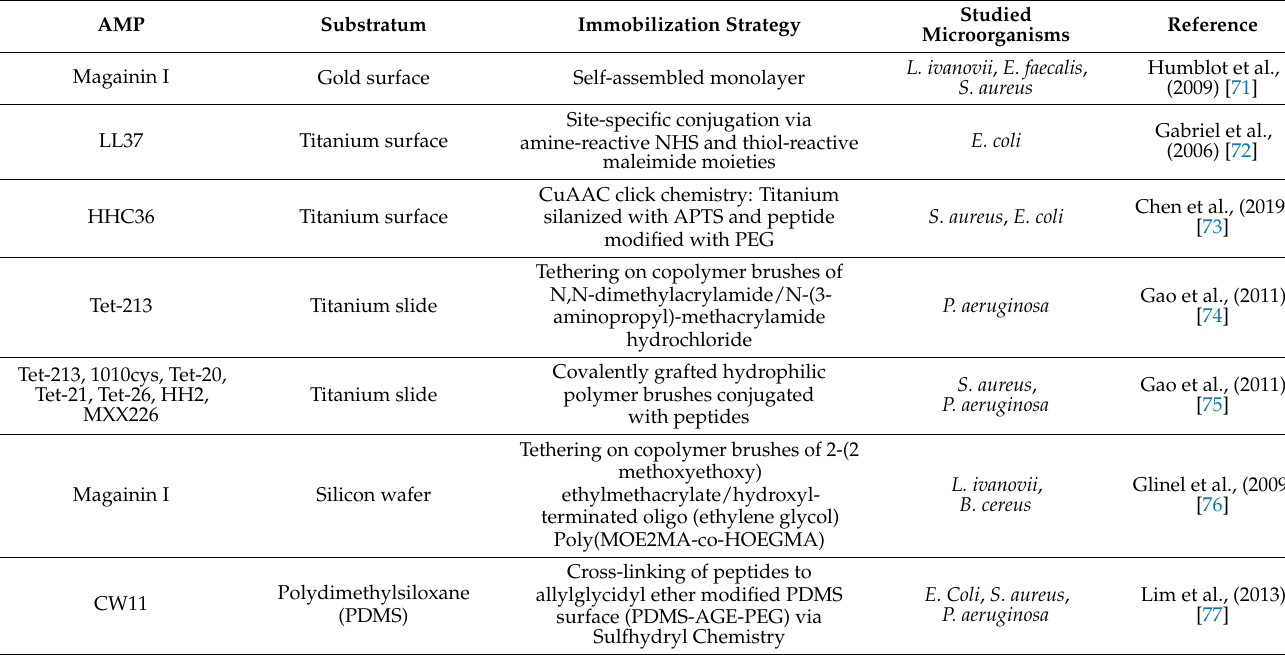
Table 2. Overview of AMP immobilization on solid surfaces and their antimicrobial